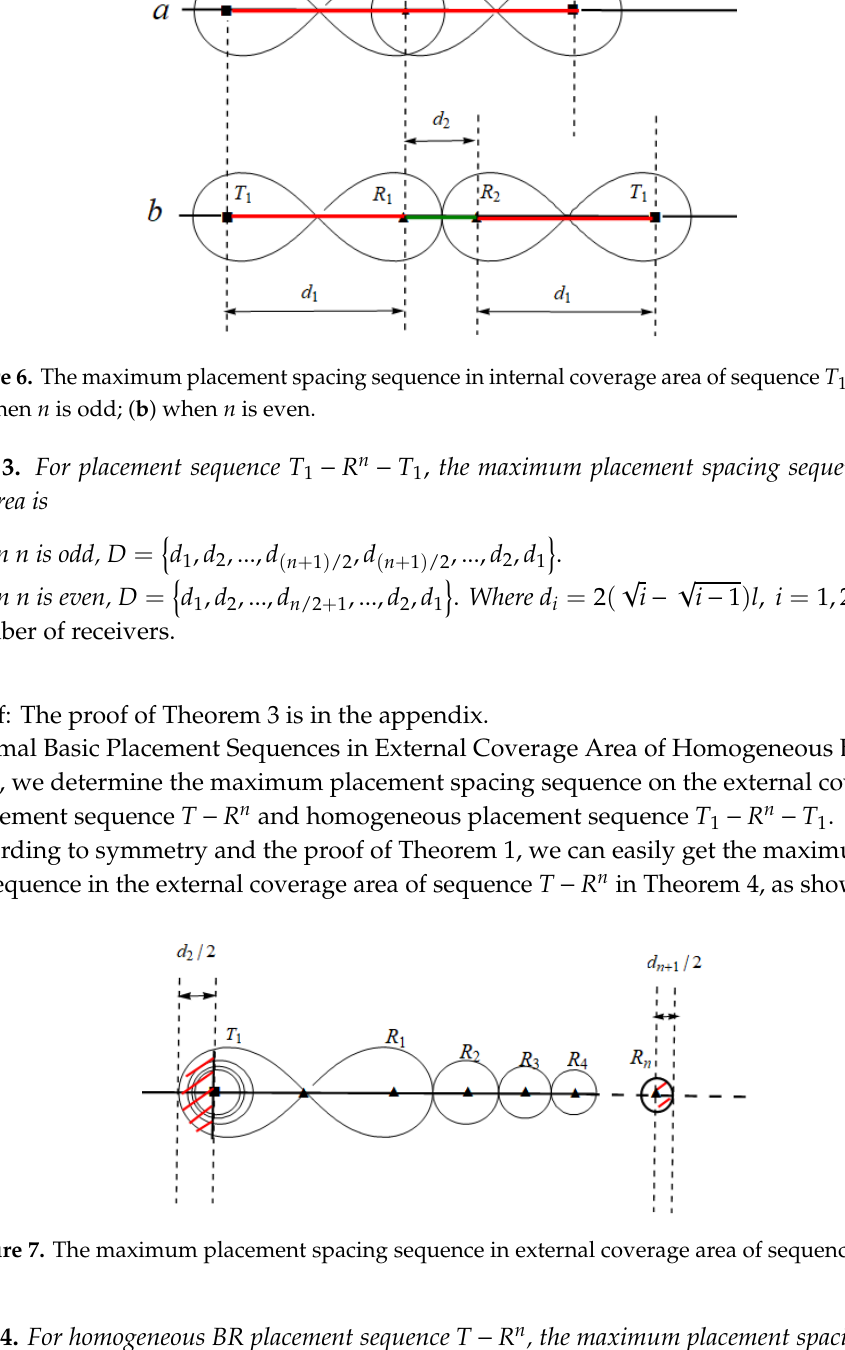
Figure 8. The maximum placement spacing sequence in external coverage area of sequence 1